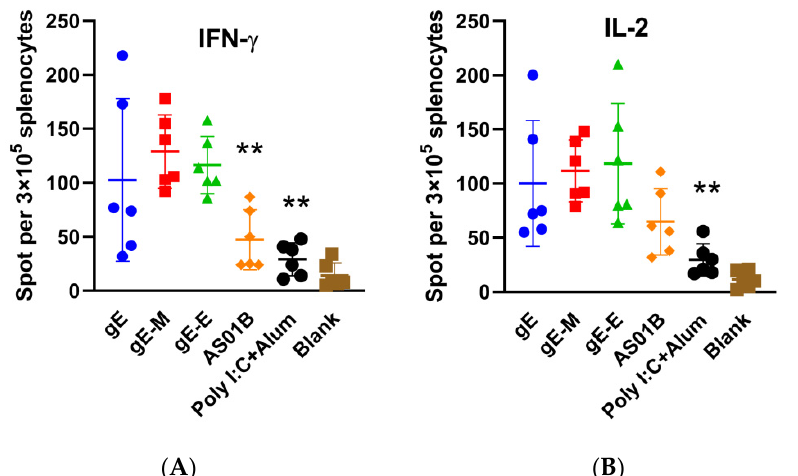
Figure 3. Enzyme-linked immunospot assay (ELISPOT) of splenocytes. ( A ) IFN- γ -producing splenocytes after gE stimulation; ( B ) IL-2-producing splenocytes after gE stimulation. ELISPOT numbers were compared using one-way ANOVA followed by Dunnett’s multiple comparisons test, with the gE-M group as a control. ** p < 0.01.